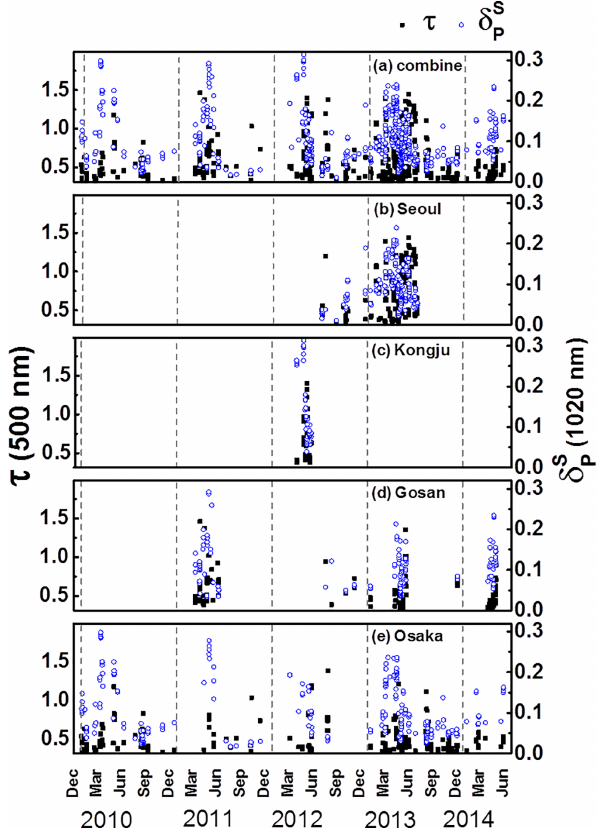
Figure 3. Aerosol optical depth ( τ ) at 500nm retrieved from AERONET sun–sky radiometer measurements (black squares) and linear particle depolarization ratio derived at 1020nm from sun– sky radiometer data ( δ S ; blue open circles). (a) Data of the four P sites taken from 2010 to 2014; (b) data taken at Seoul for two years (2012 and 2013); (c) data taken at Kongju in spring 2012; (d) data taken at Gosan during four years (2011–2014), mostly dur- ing spring; (e) data taken from 2010 to 2014 at Osaka.